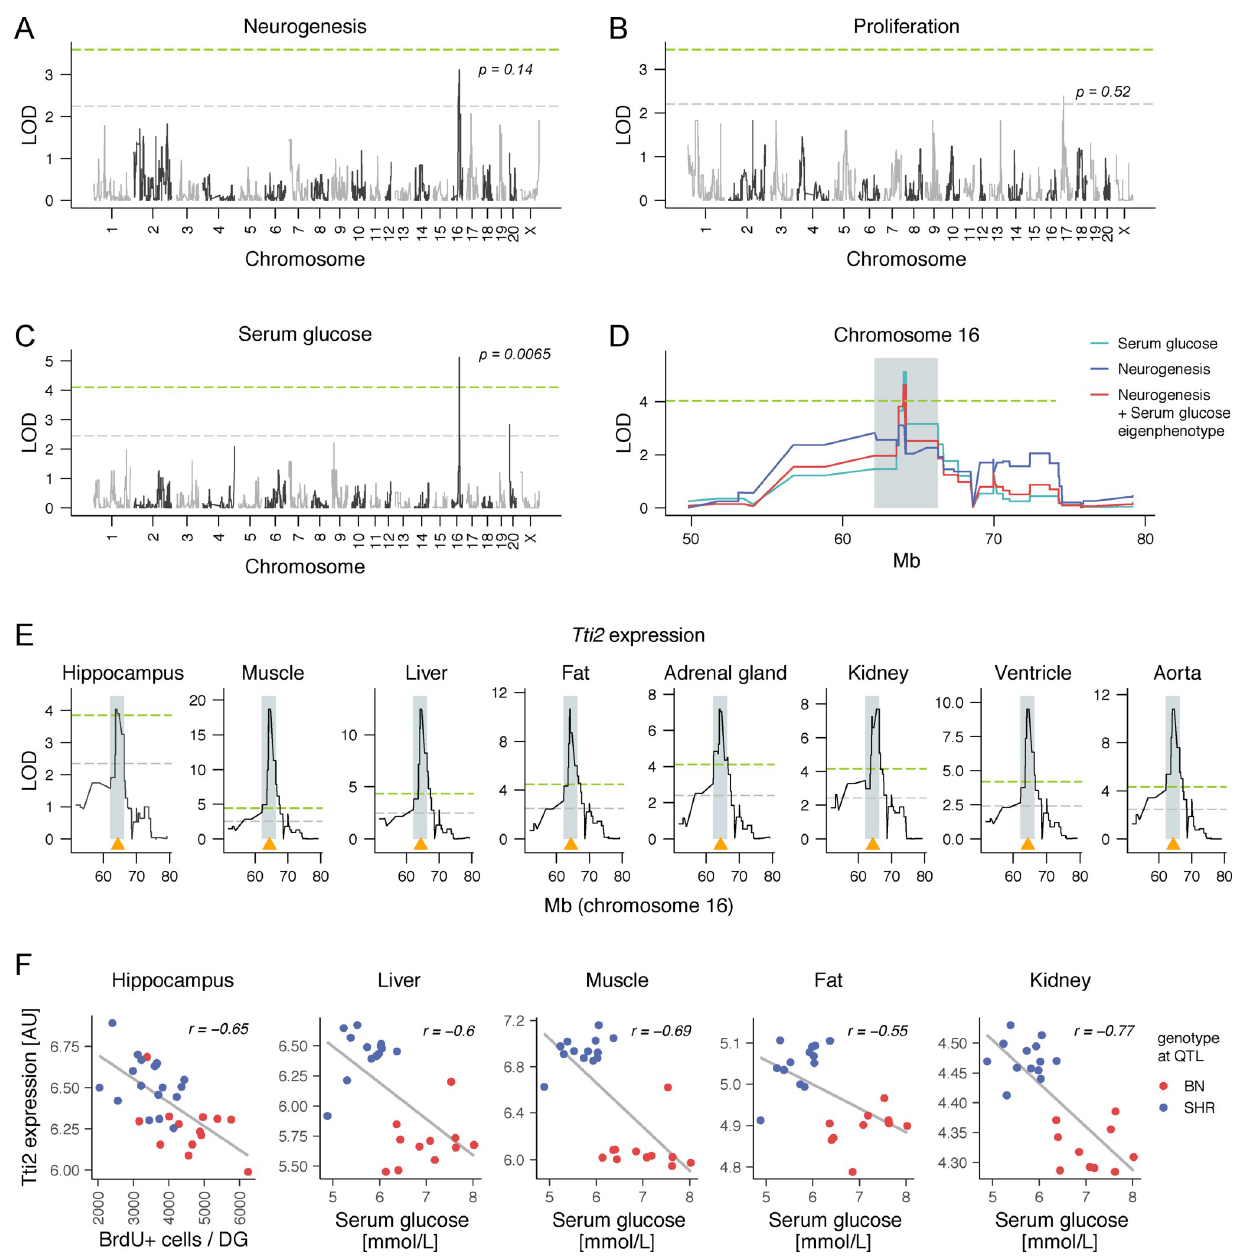
Fig 2. Tti2 is a candidate gene for common net neurogenesis and serum glucose quantitative trait locus (QTL). (A-E) Whole-genome quantitative trait locus mapping for indicated traits. The genome-wide significant ( p < 0.05) and suggestive ( p < 0.63) thresholds of the logarithm of the odds (LOD) score (green and grey horizontal dashed lines, respectively) were calculated using permutations and corrected p -values are shown adjacent to the highest association in (A-C). Suggestive threshold corresponds to an average of one false positive per genome scan [51,52].QTL for net adult neurogenesis and a positively correlating phenotype, serum glucose level, have an overlapping pattern on chromosome 16. (D) An eigenvector of the two phenotypes (an eigenphenotype– the first principal component) was used to calculate a common confidence interval for the shared QTL (shaded areas in D and E). (E) Tti2 gene, whose genomic position is indicated by an orange triangle, has a local expression QTL within the eigenphenotype QTL confidence interval on chromosome 16 in all tested tissues. For clarity, in (D) and (E) only fragments of the chromosome 16 were plotted. (F) Tti2 expression in the hippocampus or tissues relevant for regulation of glucose homeostasis, as indicated in the figure, is correlated to net neurogenesis and serum glucose. Colour specifies parental genotypes at the marker, which had the highest LOD score association with the eigenphenotype.